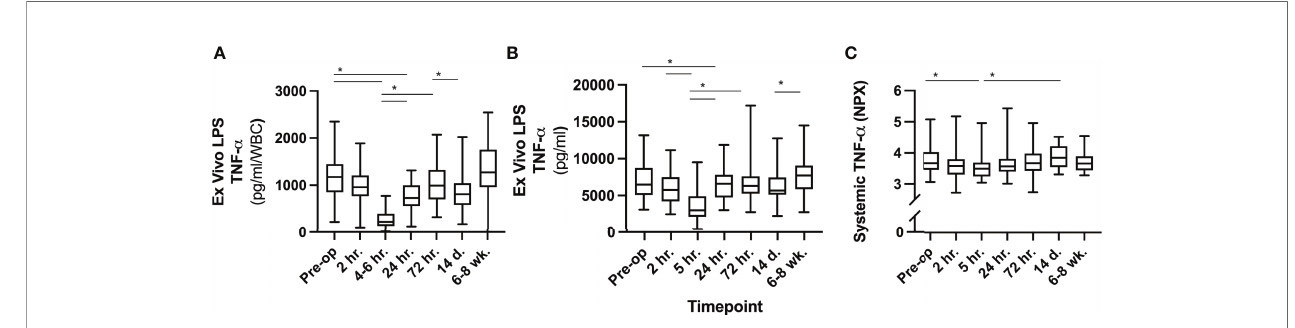
FIGURE 6 | Analyses of TNF- a . (A) TNF- a release ex vivo following LPS stimulation divided by systemic WBC at same timepoint. (B) TNF- a release ex vivo following LPS stimulation without adjustment for WBC. (C) Systemic TNF- a in circulation (serum) expressed as normalized units (NPX) on a log scale. * P-values ≤ 0.05 Tukey´s multiple comparison test, not all signi fi cant differences between timepoints are outlined. LPS, lipopolysaccharide; WBC, white blood cell count; NPX, normalized protein units.